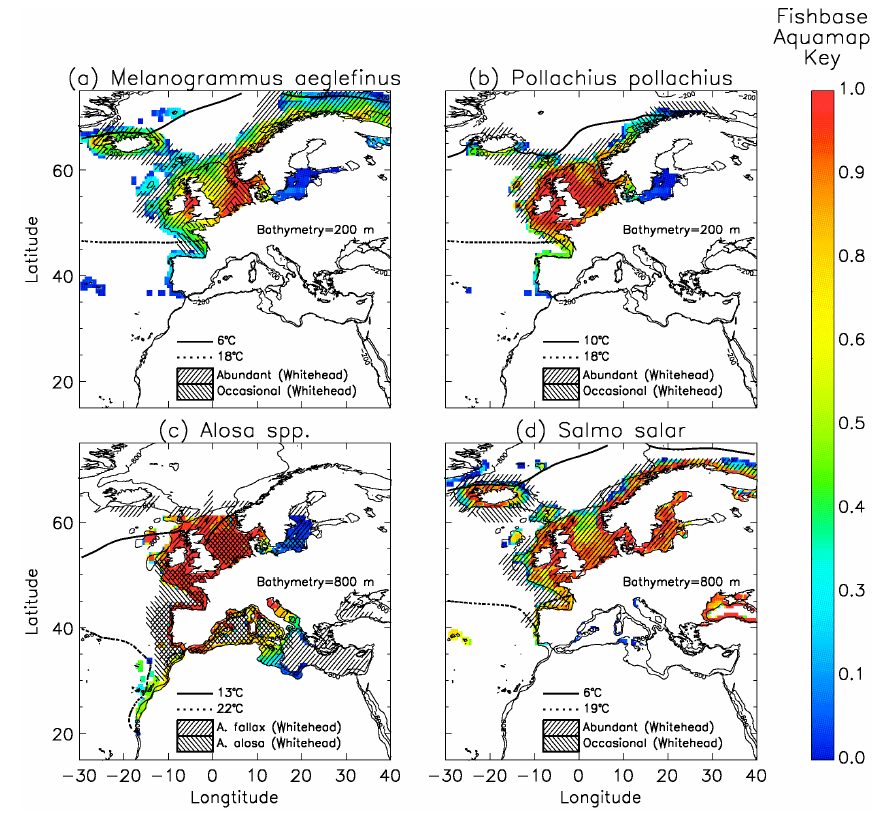
Figure 1. Spatial distribution of (a) haddock ( Melanogrammus aeglefinnus ), (b) pollock ( Pollachius pollachius ), (c) allis and twaite shad ( Alosa alosa and Alosa fallax ), and (d) Atlantic salmon ( Salmo salar ). Information is from the Fishbase Aquamap (colour-scale) and atlas of Whitehead et al. (1986; denoted by “Whitehead” and shown by hatching). The Fishbase Aquamap is a metric of relative environmental suitability that is based on the application of environmental envelopes to explain fish survey data in terms of gridded fields of bathymetry, temperature, salinity, ice cover, and primary production (Kaschner et al., 2006; Ready et al., 2010). The bathymetry is from ETOPO-5, with sea level and the single indicated contour (200m or 800m) plotted on the map. The two shad species are plotted together because their archaeozoological remains are often difficult to distinguish.